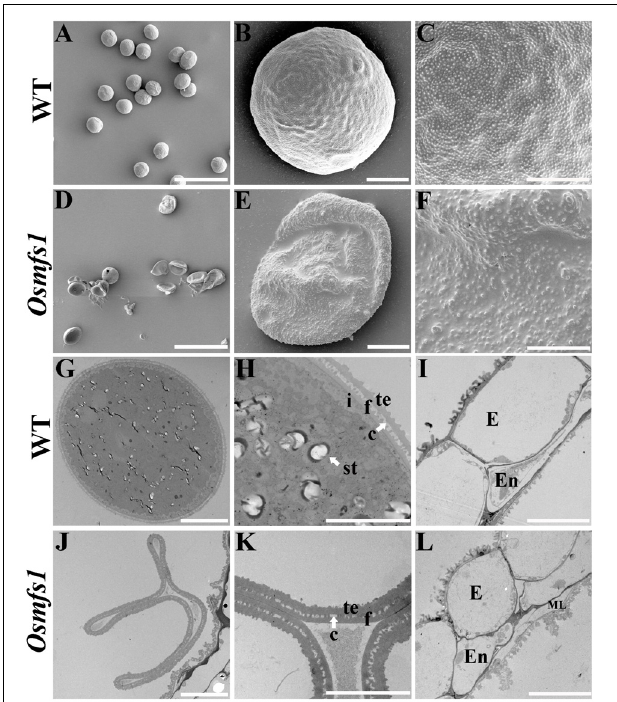
FIGURE 3 | Scanning electron micrography (SEM) and transmission electron micrography (TEM) of pollen from the WT and Osmfs1 mutant. (A) Scanning electron microscopy image of the mature WT pollen grain. (B) Magnified single pollen grain from panel (A) . (C) Further magnification showing the exine from panel (B) . (D) Scanning electron microscopy image of the mature Osmfs1 pollen grain. (E) Magnified single pollen grain from panel (D) . (F) Further magnification showing the exine from panel (E) . (G) Transmission electron microscopy image of the WT pollen. (H) Magnification of the pollen wall from panel (G) . (I) Transmission electron microscopy image showing the WT anther wall. (J) Transmission electron microscopy image of the Osmfs1 pollen. (K) Magnification of the pollen wall from panel (J) . (L) Transmission electron microscopy image showing the Osmfs1 anther wall. c, columella; st, starch; i, intine; f, foot layer; te, tectum; E, epidermis; En, endothecium; ML, middle layer. Bars = 100 µ m in panels (A,D) , 10 µ m in panels (B , E , G , J , I,L) ,